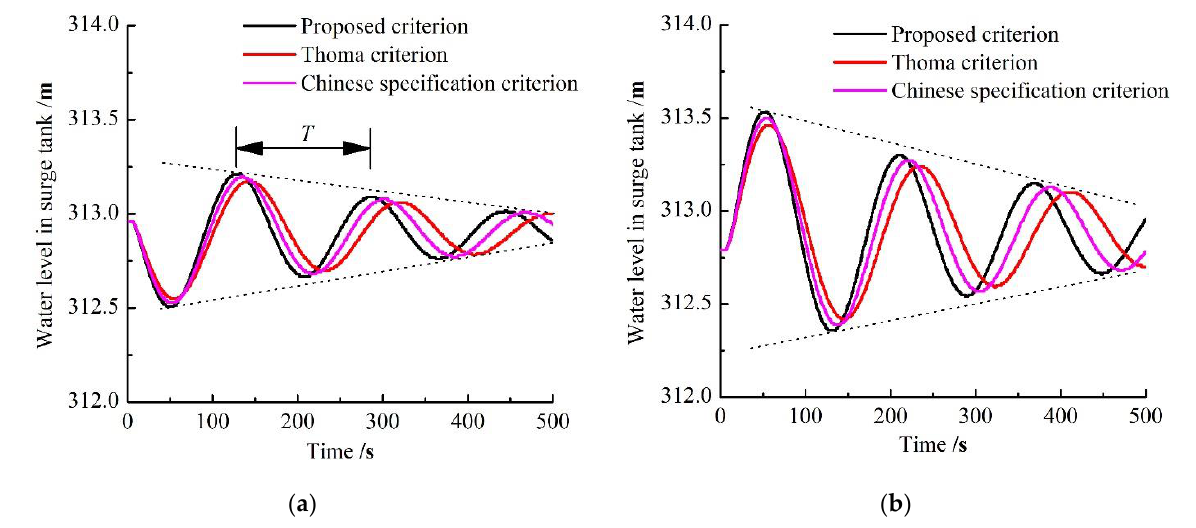
Figure 5. WLO process of the ST in case 1: ( a ) Working condition 1. ( b ) Working condition 2. Table 3. Extreme values and periods of WLO in the ST.